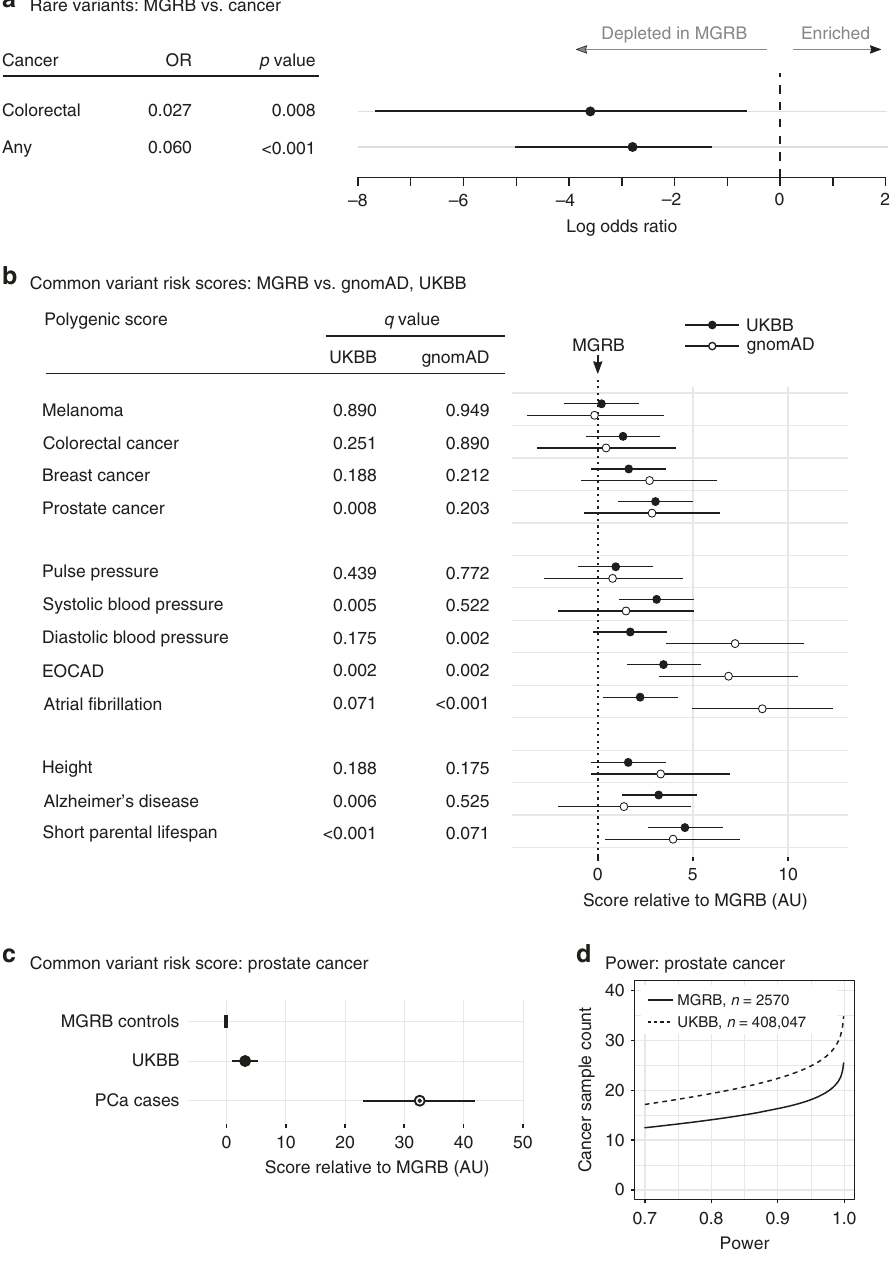
Fig. 1 The MGRB is depleted for genomic risk relative to reference and disease cohorts. a The rate of rare pathogenic variants in tumour suppressor genes is lower in MGRB than in a cohort of cancer cases (log odds for an individual to carry a pathogenic tumour suppressor variant shown). b The MGRB also has lower polygenic score (PS) estimates for a range of phenotypes, when compared to the gnomAD non-Finnish European population and the UK Biobank samples. MGRB is the reference in b , with PS mean set at zero; bootstrap 95% con fi dence intervals are shown for the difference in PS between MGRB and the reference cohorts (UKBB or gnomAD); higher values indicate a higher polygenic score in UKBB or gnomAD. q -Values represent false discovery rate estimates by the Benjamini – Hochberg method 70 . c The MGRB has lower PS compared to prostate cancer cases, here considering only samples from the 45 and Up Study. d For any given sample size, the MGRB has greater statistical power to detect PS difference from a case cohort than UKBB, demonstrated here for prostate cancer. AU arbitrary